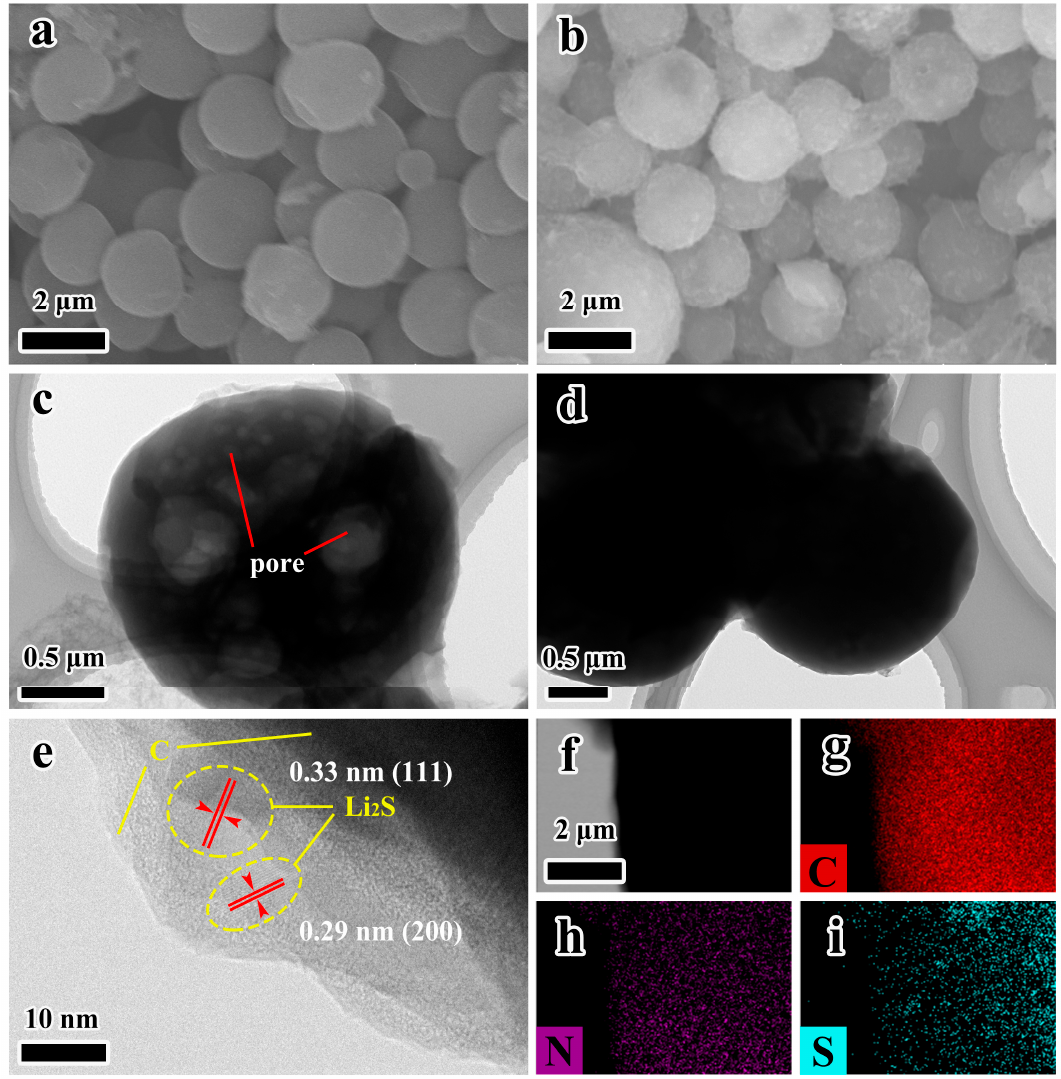
Figure 3. SEM images of ( a ) NPCMs and ( b ) NPCMs–Li 2 S; TEM images of ( c ) NPCMs and ( d ) NPCMs–Li 2 S; ( e ) HRTEM image of NPCMs–Li 2 S; ( f ) STEM image of NPCMs–Li 2 S and corresponding elemental distributions of ( g ) C, ( h ) N and ( i ) S.